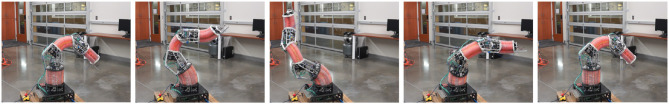
Series of joint configurations showing how this six degree of freedom pneumatic continuum robot can move.